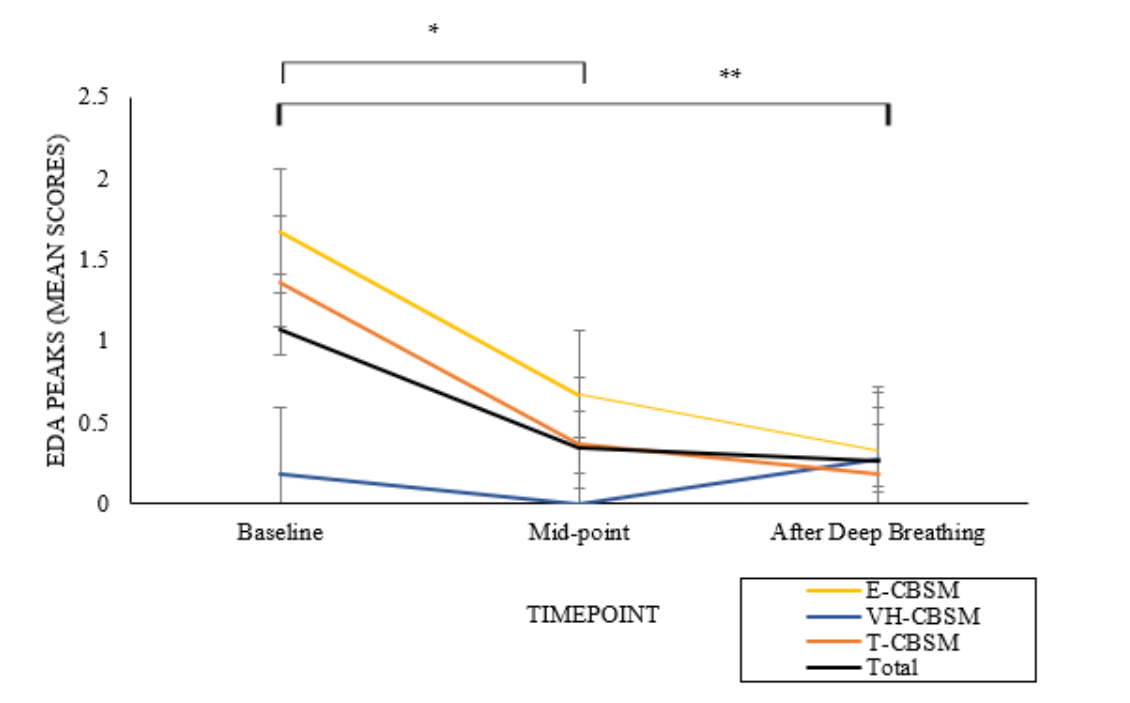
Figure 4. A significant main effect of time and a trend towards a main effect of condition on electro- dermal activity. Note, standard error bars are depicted (** p < 0.01, * p < 0.05). EDA= electrodermal activity.